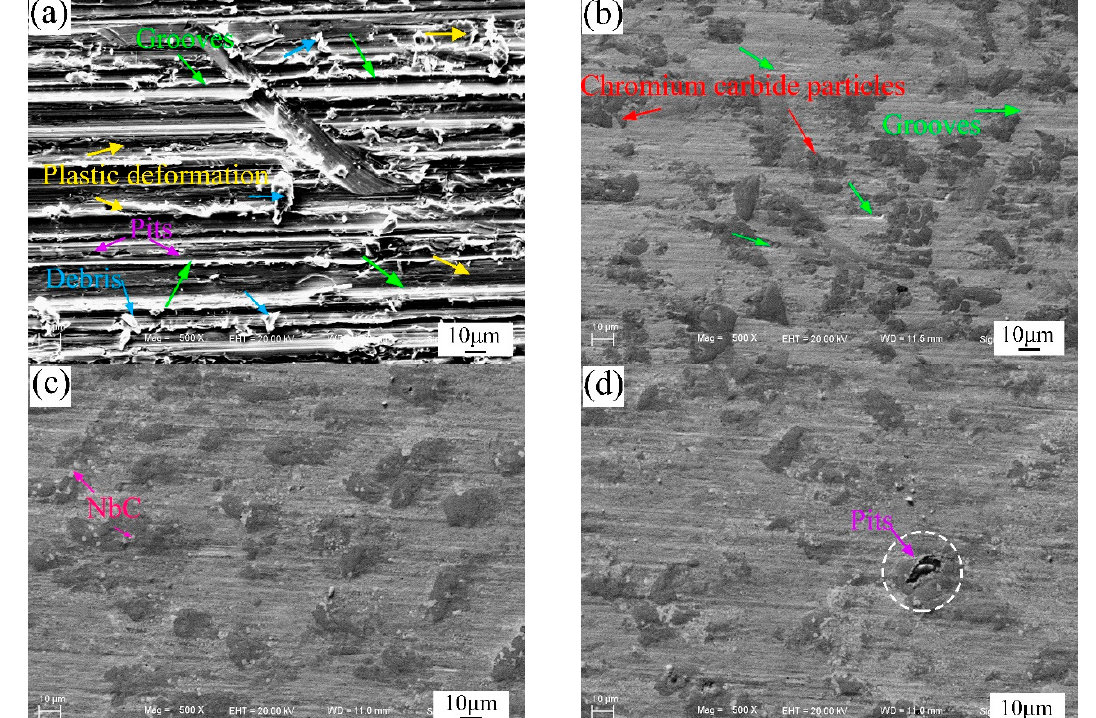
Figure 9. Worn surface morphologies of the substrate and the composite coatings ( a ) substrate, ( b ) C0, ( c ) C4, and ( d ) C5.